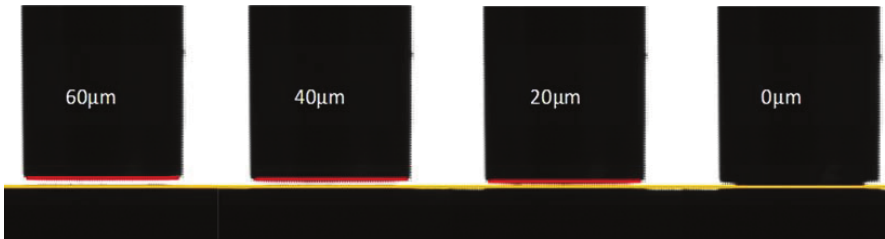
Figure 10. Images with different